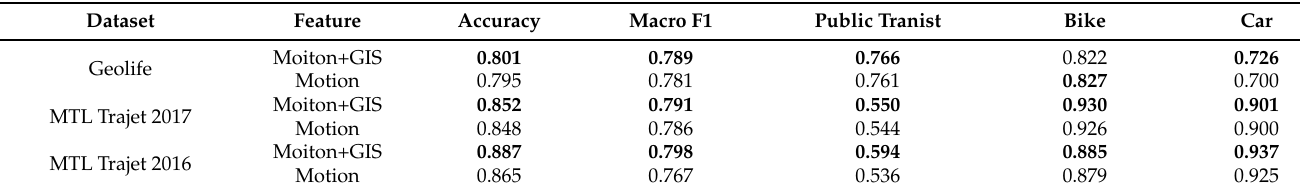
Table 9. The influence of geographic